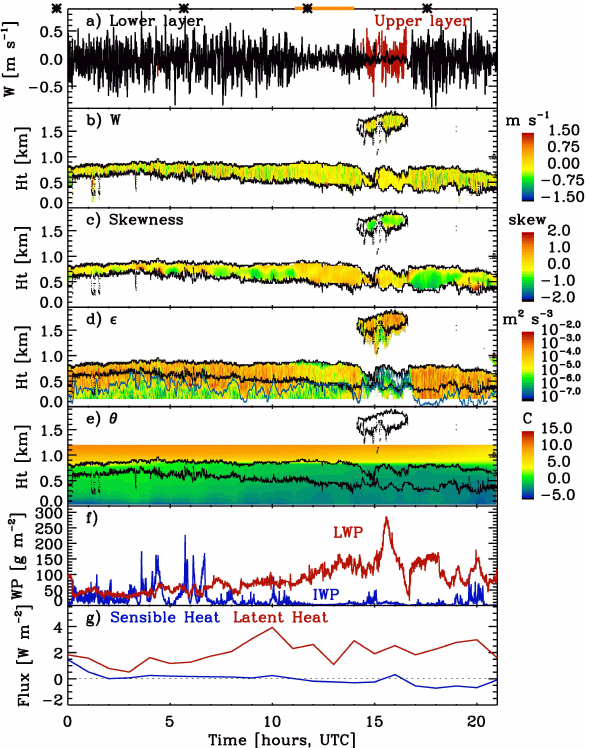
Fig. 6. Remote-sensor-derived cloud and atmosphere dynamical properties for 29 August 2008 (Case #2), including (a) layer-mean vertical velocity, (b) vertical velocity within the liquid cloud lay- ers, (c) skewness of vertical velocity over running 30min windows, (d) turbulent dissipation rate, (e) potential temperature, (f) LWP (red) and IWP (blue) for clouds below 2km, and (g) surface turbu- lent sensible (blue) and latent (red) heat fluxes. Liquid cloud bound- aries are given in black in (b–e) , while the base of the cloud-driven mixed layer is given in blue in (d) . The black line in panel a is for the lower cloud layer, while the red line is for the upper altocumulus layer. The orange bar along the top axis shows the time period when a second upper cloud had descended below 5km. Black stars on the top axes designate the launch time for radiosondes shown in Fig.